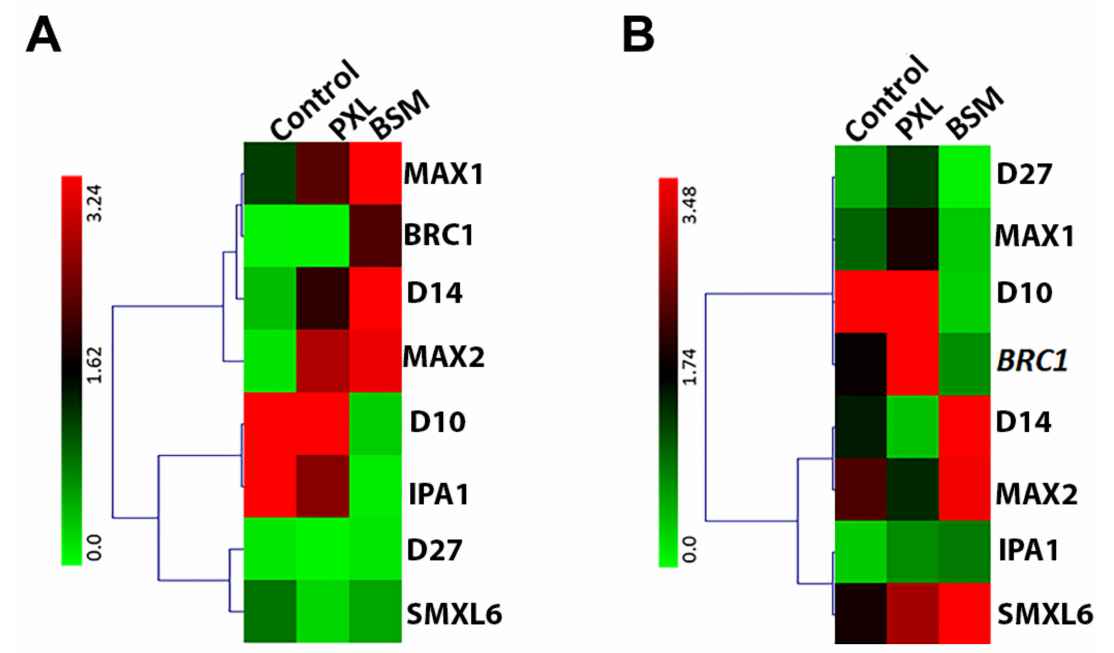
Figure 5. Response of SL-related genes to herbicide stresses in watermelon after three days of treatments. The expression level of SL biosynthesis, signal transduction, and downstream genes in ( A ) roots, and ( B ) leaves under different herbicide stress for three